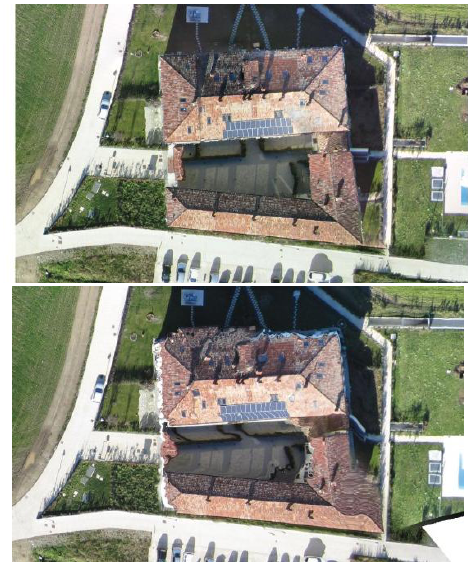
Figure 9 - Differences of ortophotos (AP up - P4 down): detail in the edges of some